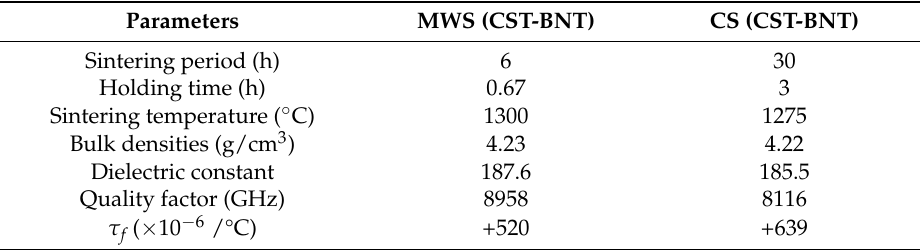
Table 1. Microwave properties of 0.95CST–0.05BNT samples prepared with different sintering